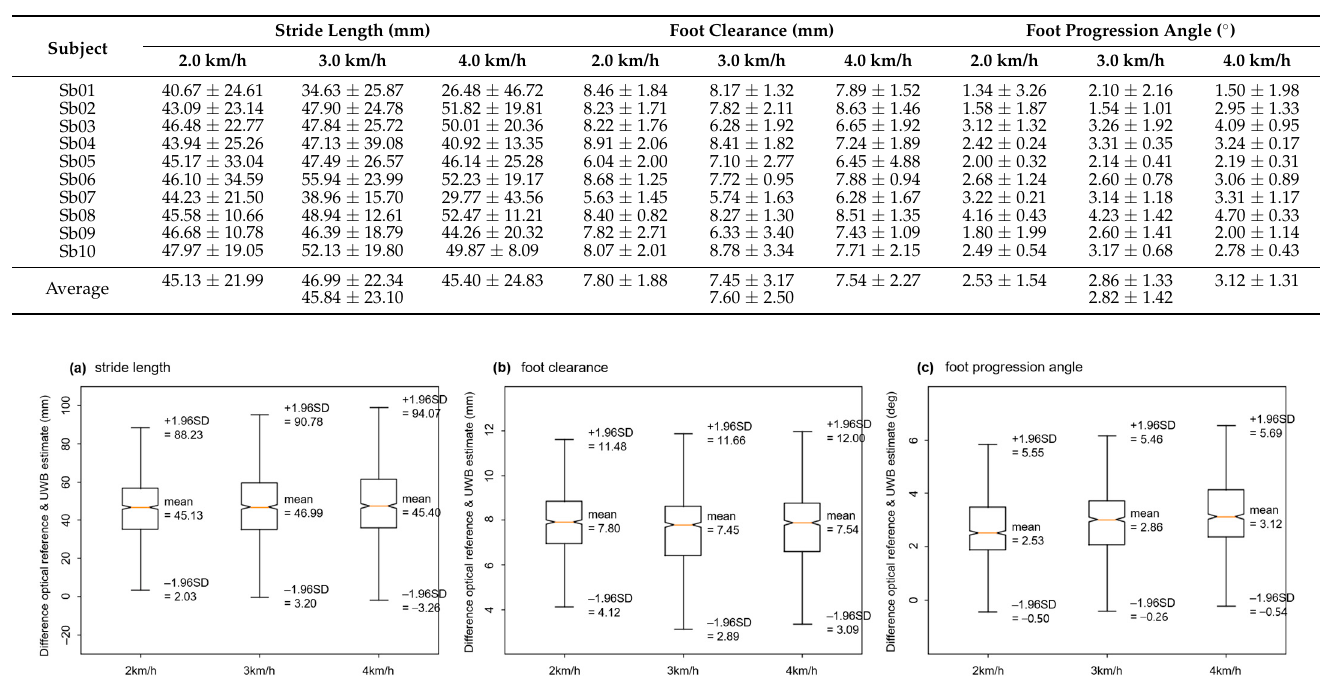
Table 2. Means and standard deviations of differences in gait parameters between motion capture and UWB approach.